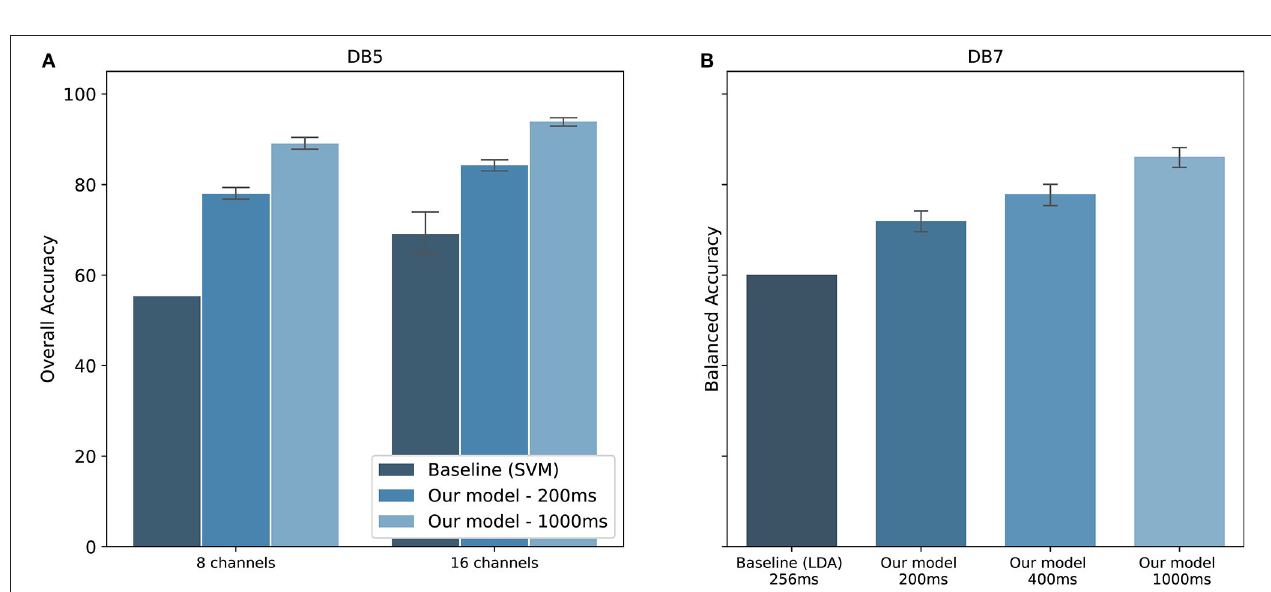
FIGURE 7 | Confusion matrices for the proposed model trained on data from amputees #1 (A) and #2 (B) .